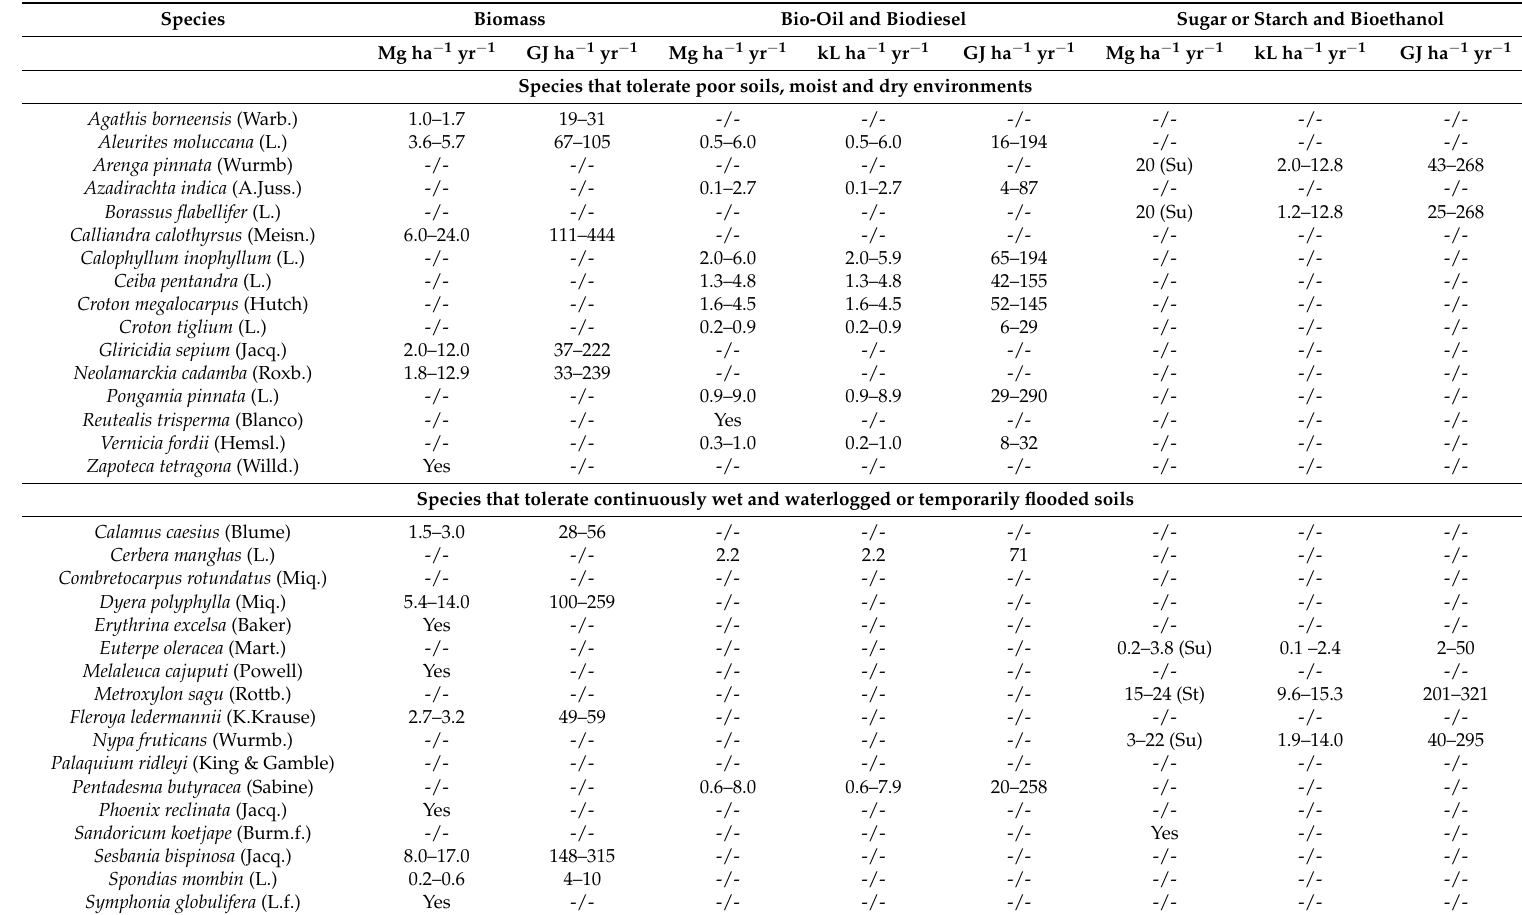
Table 2. Potential annual biomass, bio-oil, sugar (Su), and starch (St) productivity in Mg ha − 1 yr − 1 of species used/potentially suitable for forest-based